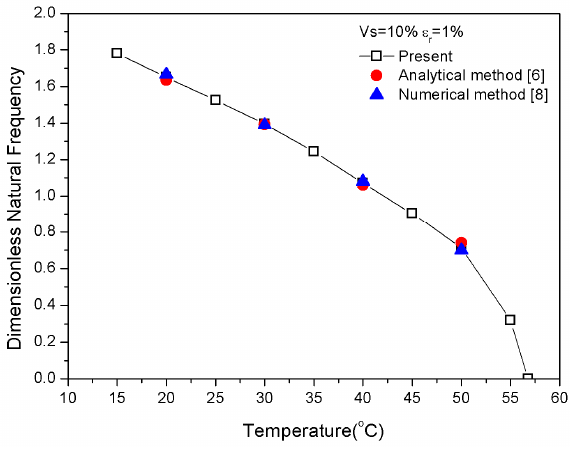
Figure 2. SMA modulus of elasticity and recovery stress vs. temperature. Table 1. Material properties of the shape memory alloy (SMA), graphite, and epoxy matrix.